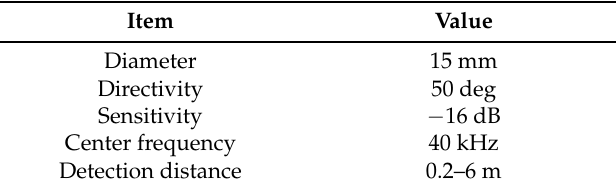
Table 1. Sensor main technical